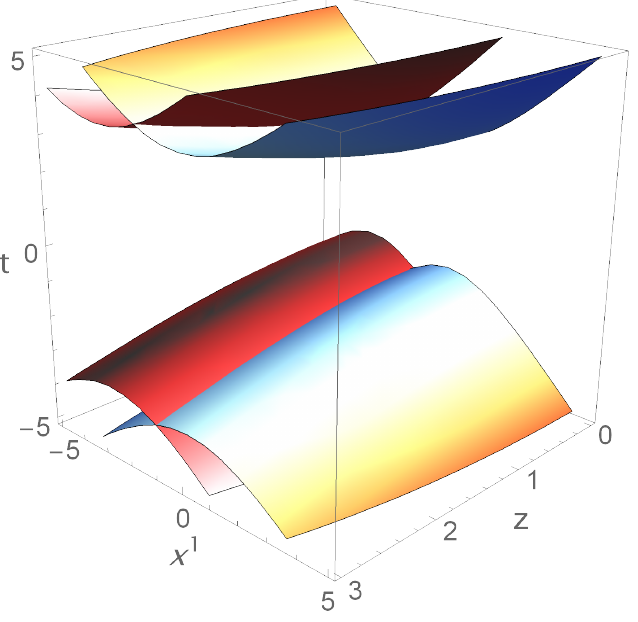
Figure 8 . Intersection of two L 2 shocks, where the sources are separated in the x + and x 1 directions. This is plotted at finite x 3 and x 2 = 0